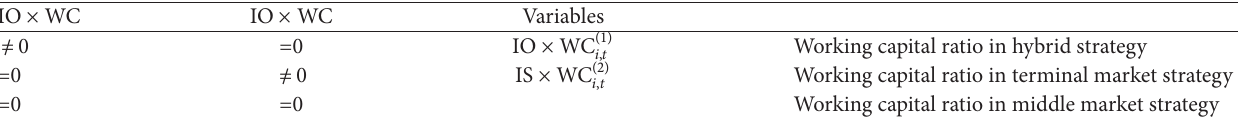
Table 6: Measures of interaction of margin